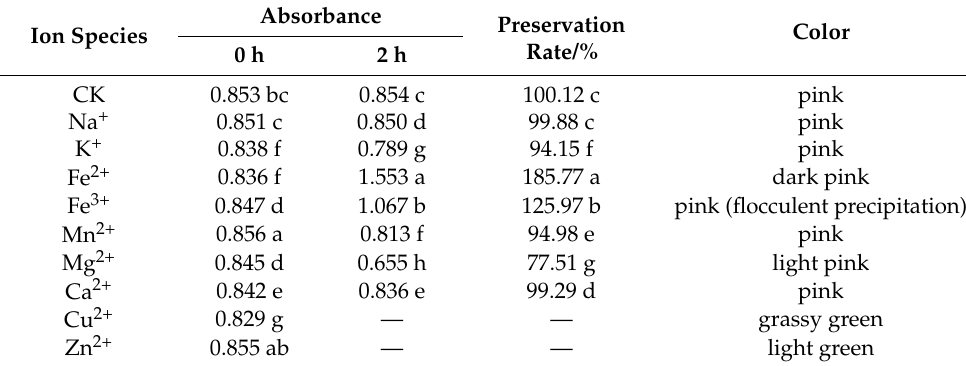
Table 4. Effect of the metal ions on the stability of the pink